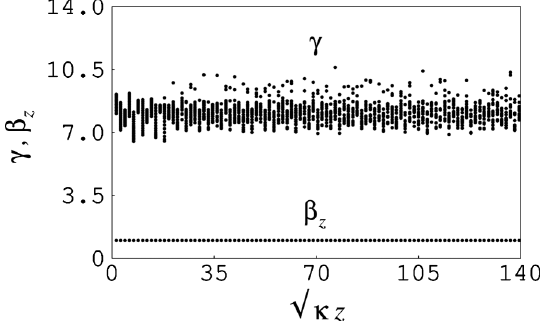
FIG. 3. The time history of (cid:2) z and (cid:1) for the parameters of Fig.